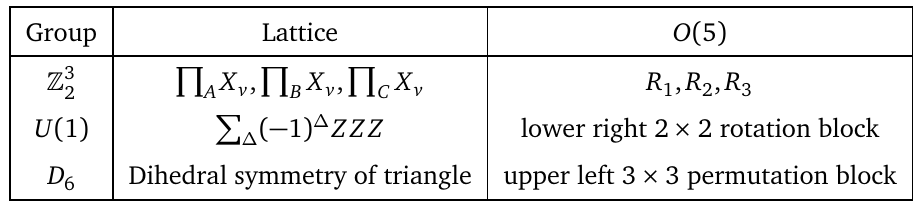
Table 1: Correspondence between lattice and continuum symmetries. We consider the (cid:90) 3 SPT model on the triangular lattice as in Eq. (6). The vicinity of the multi- 2 critical point (red dot in Fig. 2) is described by SO ( 5 ) deconfined quantum criticality. ∈ SO ( 5 ) (for i = 1,2,3,4) are defined as diagonal matrices with − 1 in the Here, R i i th and 5 th